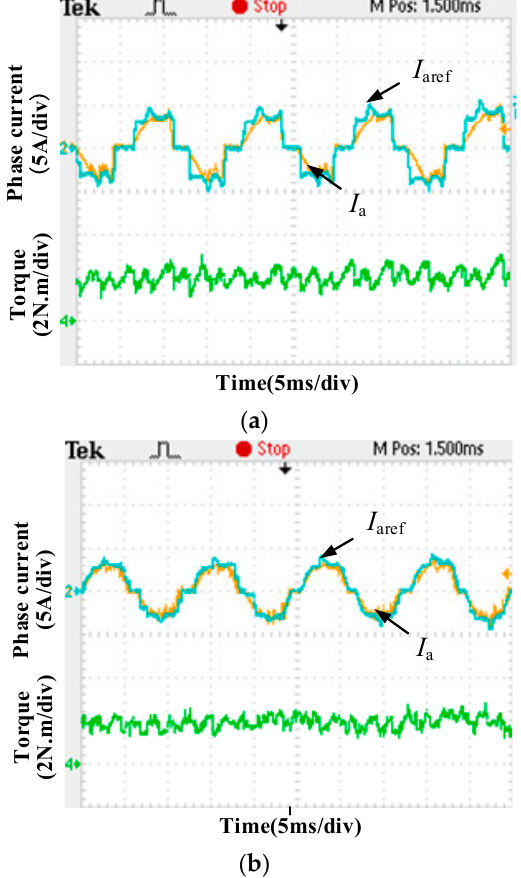
Figure 12. Experimental results for comparison: ( a ) conventional commutation strategy; ( b ) proposed commutation strategy.